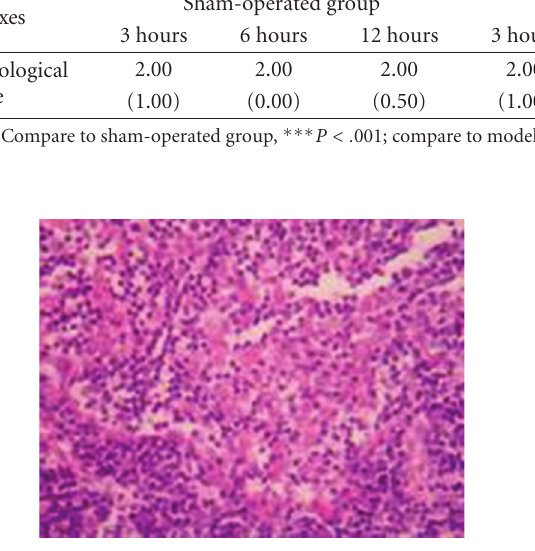
Figure 5: Treated group: 28 days in OJ rat expansion of lymph sinuses, hyperplasia of sinus cells, and infiltration of inflammatory cells, HE ×